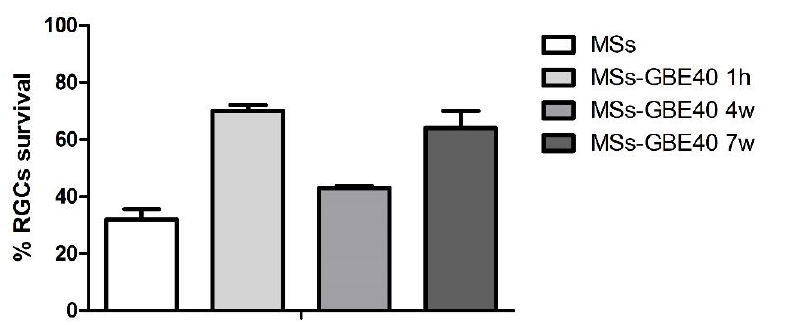
Figure 9. Bioactivity of GDNF/BDNF was demonstrated at 1 h, 4, and 7 weeks of the release study, increasing RGC survival by 70%, 43%, and 64%, respectively, compared to Blank MSs. Blank MSs (MSs); GDNF/BDNF/VitE(40)-loaded PLGA microspheres (MSs-GBE40).